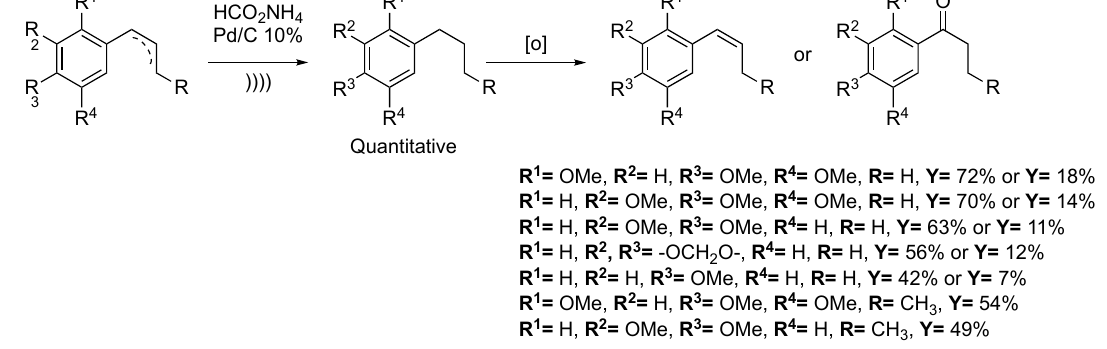
Scheme 31. Synthesis of arylalkenes and arylalkanones. The ultrasonic bath used f = 20 kHz and P input = 400 W. Adapted from Joshi et al. [137].